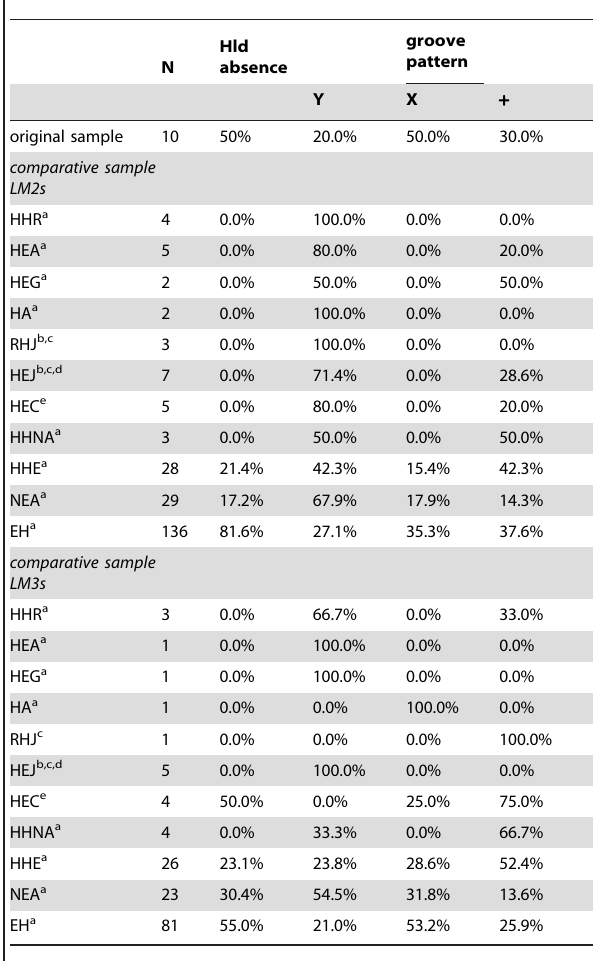
Table 2. Proportions (% absence) of the Hld and occlusal groove pattern occurrence in the new Javanese fossil human dental sample compared to the figures from eleven extant and fossil human